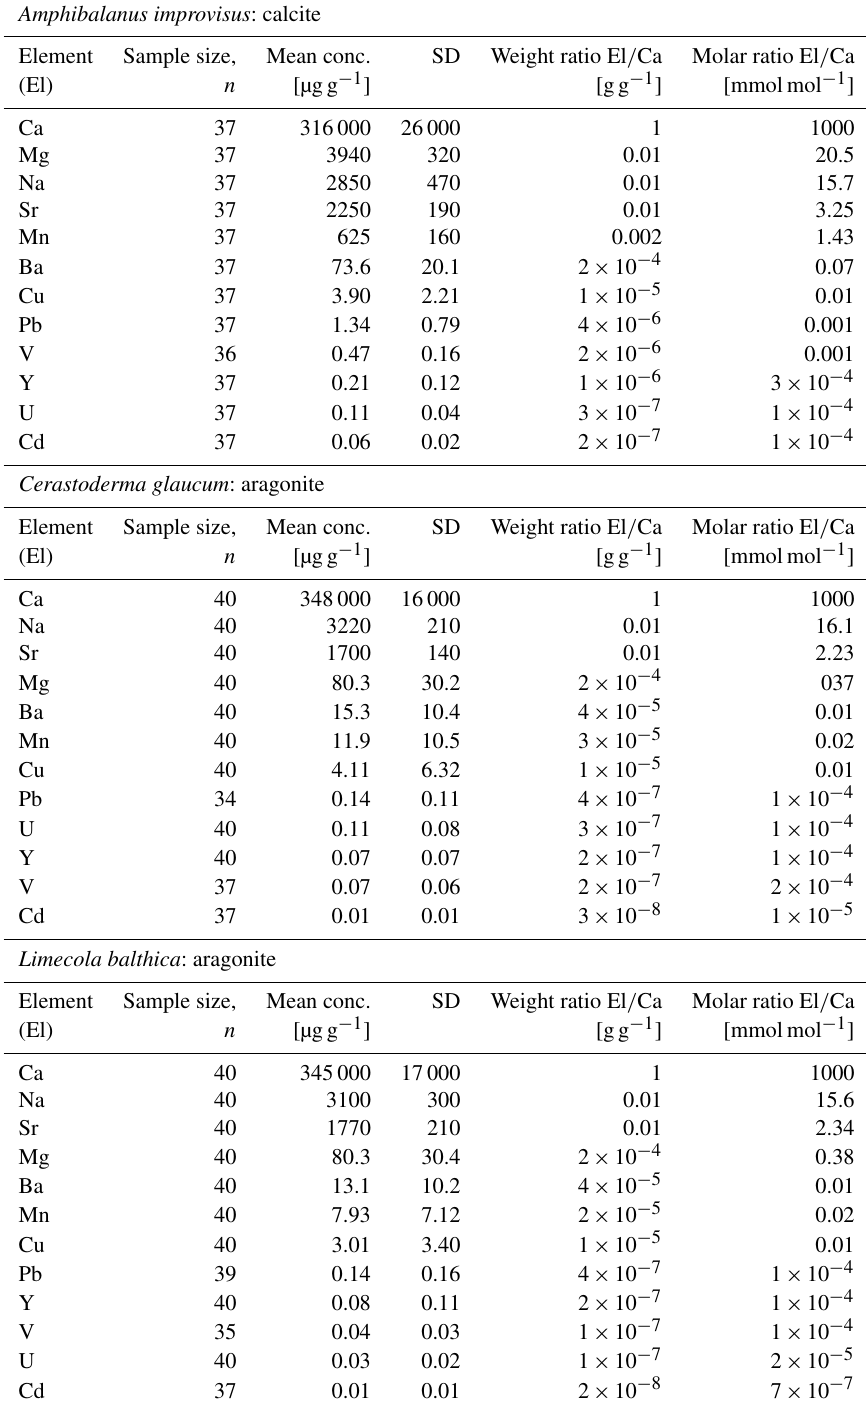
Table 3. Elemental concentrations in shells of studied organisms, presented in decreasing order of means for each species (SD represents standard